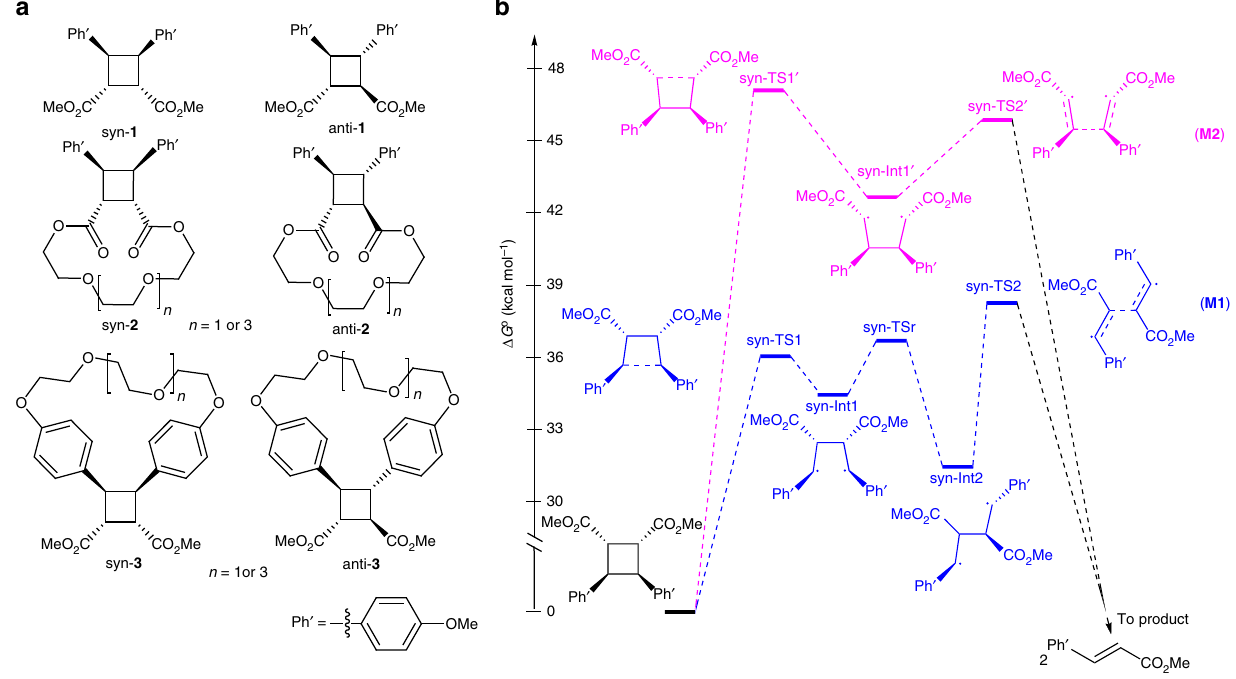
Fig. 1 Cinnamate dimers and the strain-free dissociation mechanism. a The chemical structures of the studied cyclobutane derivatives. b Mechanisms of dissociation of syn- 1 calculated at the uMPW1K/6-31 + G (d) level of the DFT in vacuum. The barrier for rotation around the Ph ’ C – CPh ′ bond of syn-Int ’ is comparable to that for syn-Int (3.5 kcal mol − 1 ) but the corresponding rotated syn-TS2 ’ r conformer is 1.8 kcal mol − 1 less stable than syn-TS2 ’ and bond rotation in syn-Int ’ is only important under force (see Supplementary Figs. 1 – 3 for dissociation mechanisms of anti- 1 with and without